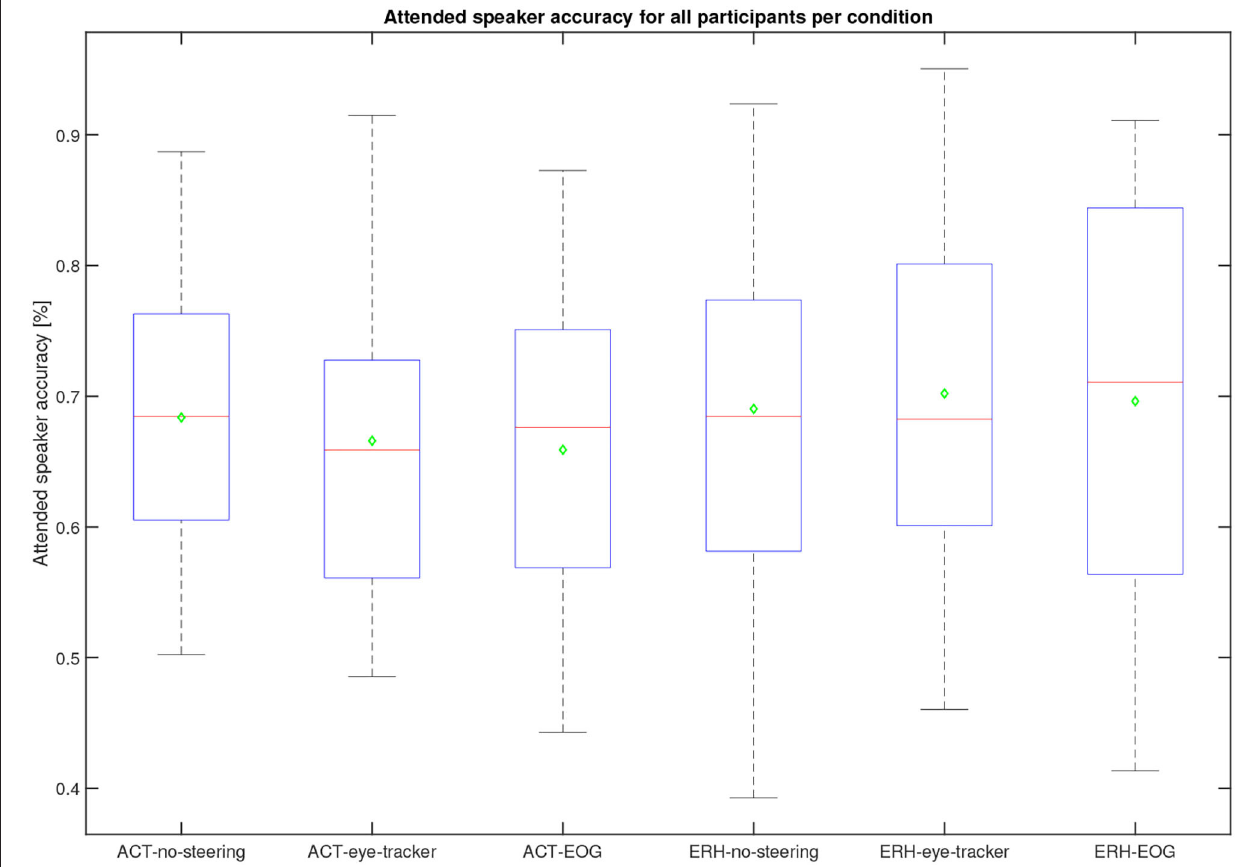
FIGURE 9 | Average speaker accuracy across 22 participants (two were omitted due to missing data for one condition or more) for the different conditions. The median is the red line, the mean is a green diamond, the box represents the 25 and 75 th percentile, the whiskers extend to the extreme values, and the red crosses represent individual outliers. These data were computed during the experiment. No significant difference is found between any of the conditions and